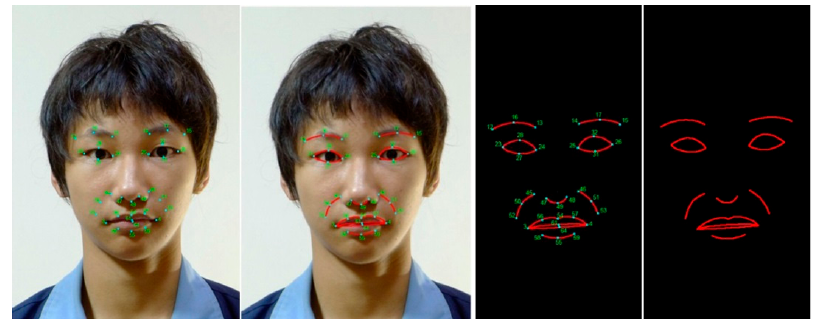
Figure 2. Feature point outline map formed by connecting facial feature points.